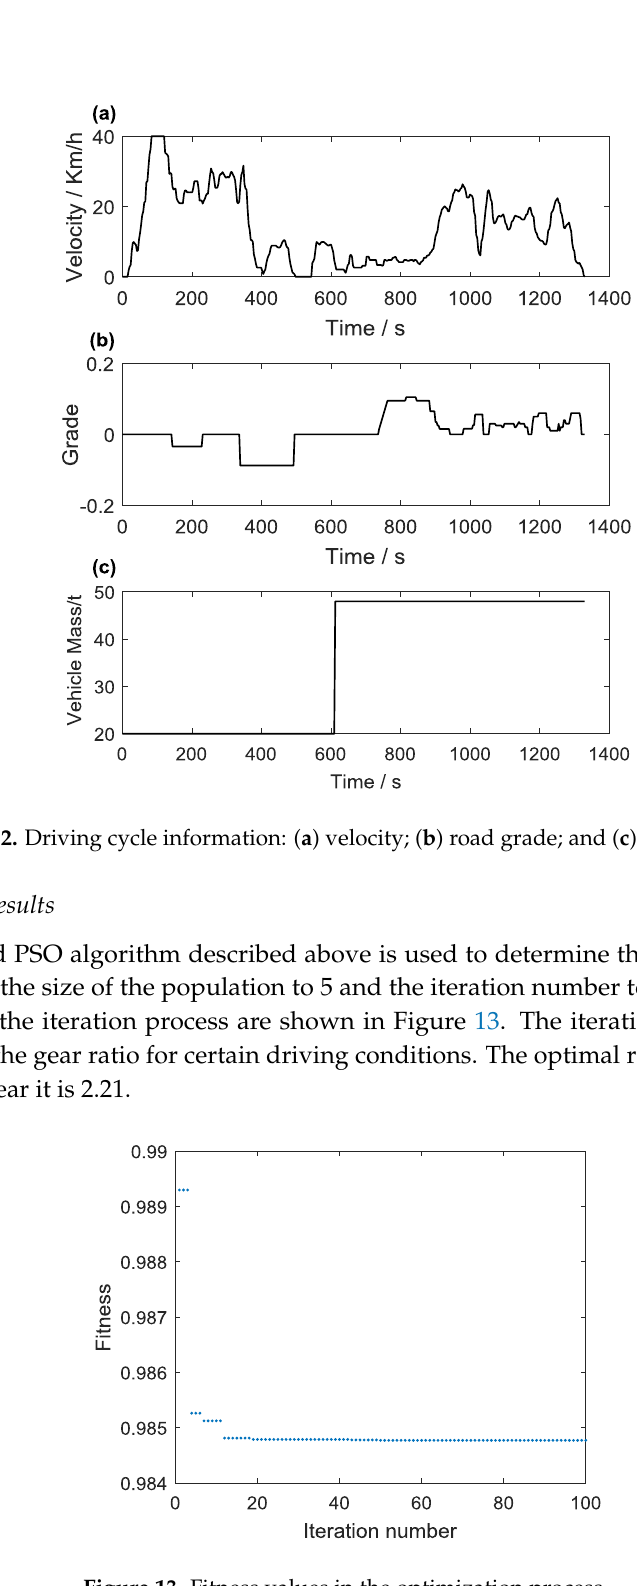
Figure 13. Fitness values in the optimization process.